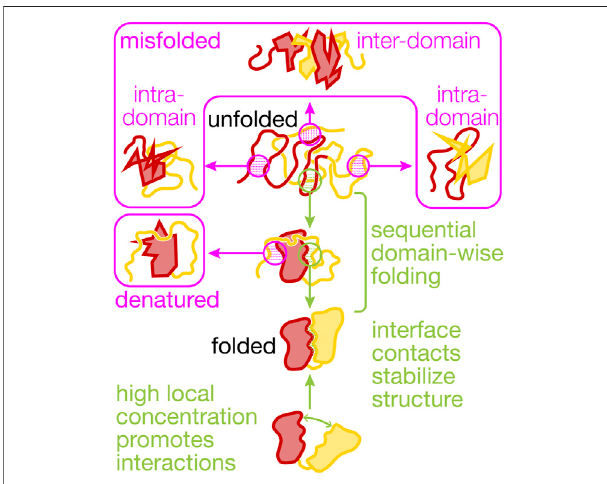
FIGURE 1 | Productive and non-productive interactions between domains in a protein. The cartoons visualize non-productive interactions (magenta) and productive interactions (green) within and between two domains (N-terminal, red, and C-terminal, yellow) that shape multi- domain(mis)foldinganddynamics. Co-translationalfoldingabetssequential domain-wise folding, reducing inter-domain misfolding. Interactions with the ribosome and molecular chaperones further reduce misfolding and the destabilizing interactions between the unfolded yellow and the folded red domain that results in denaturation. Non-native states are prone to irreversible aggregation (not shown here). Interface contacts between the folded domains can be mutually stabilizing and are promoted by high local concentrations that result from covalently linking the domains in a single polypeptide